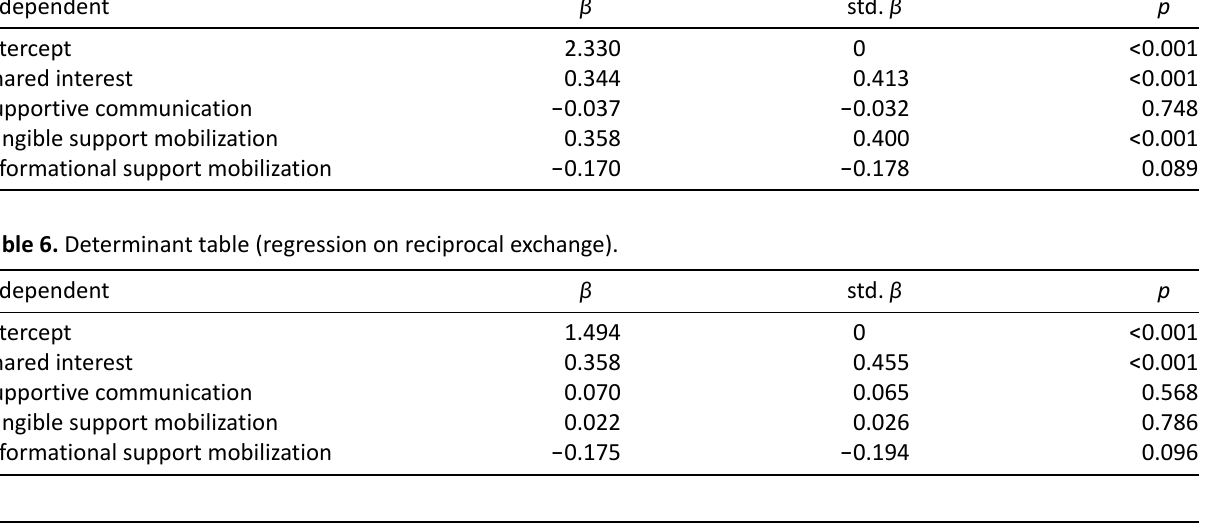
Table 5. Determinant table (regression on neighborhood sense of community). Independent